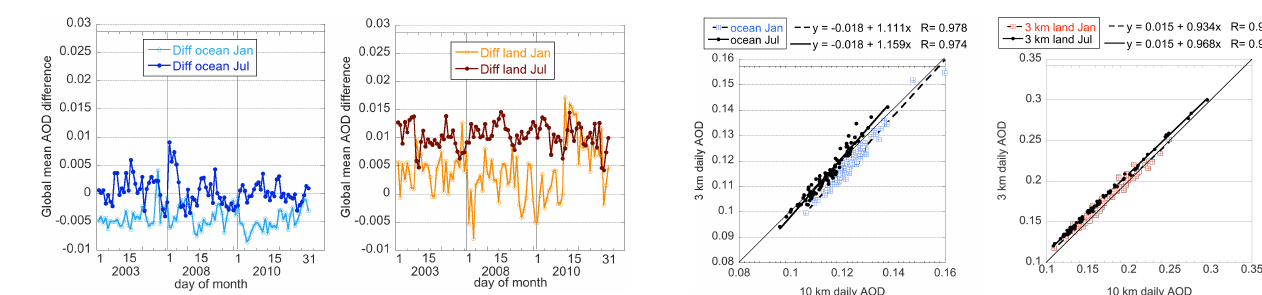
Fig. 8. Daily global mean aerosol optical depth (AOD) at 550nm for the 93 days of the months of January, and 93 days of the months of July 2003, 2008 and 2010 calculated from the 3km product plotted against the same calculations used in the 10km product. The left plot is for ocean, and the right plot is for land. Note the different scales on the axes for the ocean and land